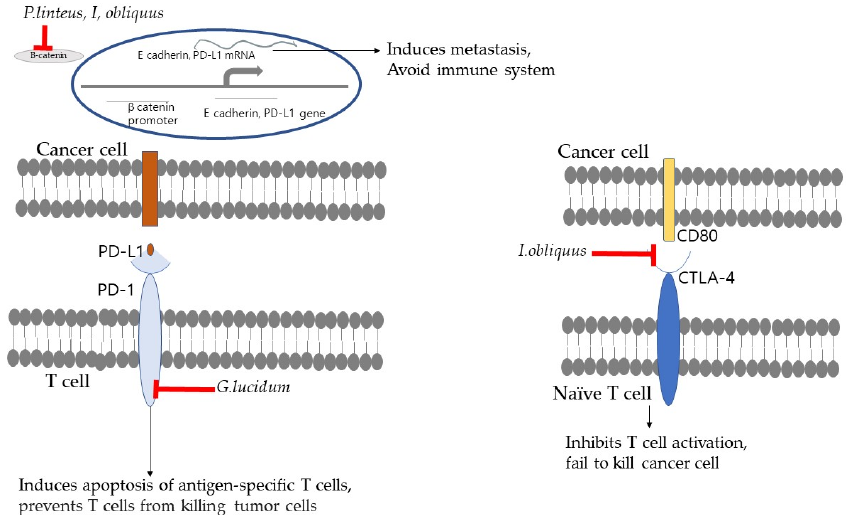
Figure 2. The illustration of the anticancer mechanisms of mushrooms by inhibiting the PD ‐ 1 pathway and CTLA ‐ 4/CD80 pathway. and CTLA-4/CD80